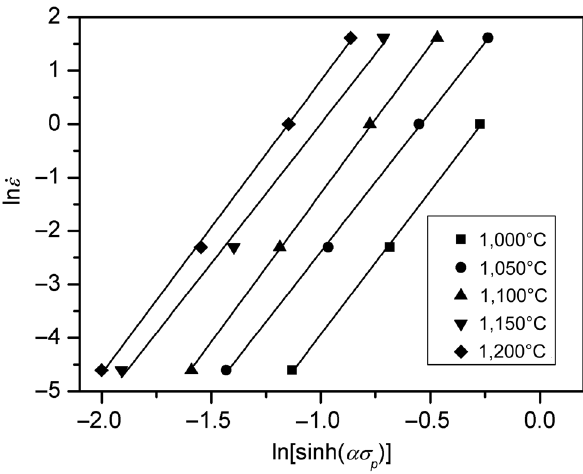
Figure 4: Relationships between ln _ " and ln[sinh( ασ p )].